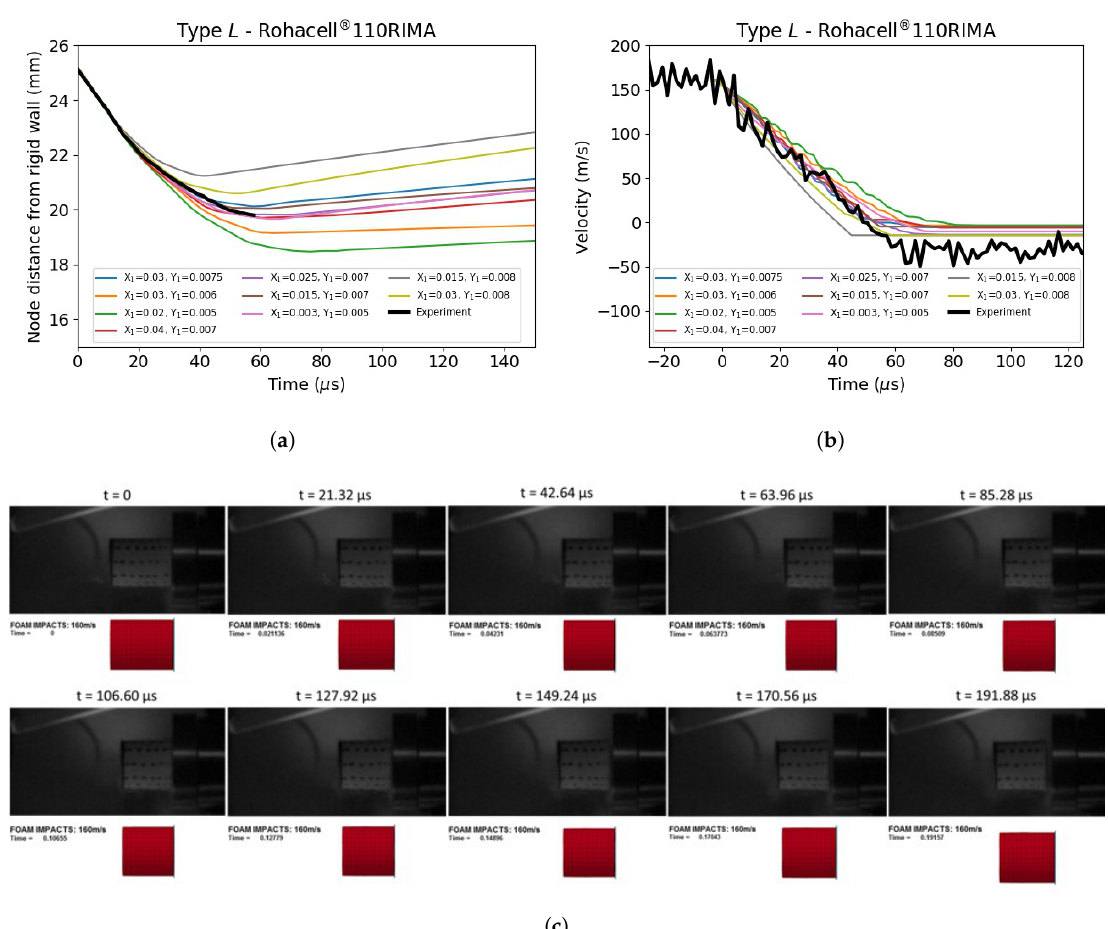
Figure 15. FE study for Rohacell R (cid:13) 110RIMA. ( a ) Crash distance vs. time; ( b ) velocity vs. time; ( c ) comparison between experimental and FE results for X 1 = 0.025 and Y 1 =